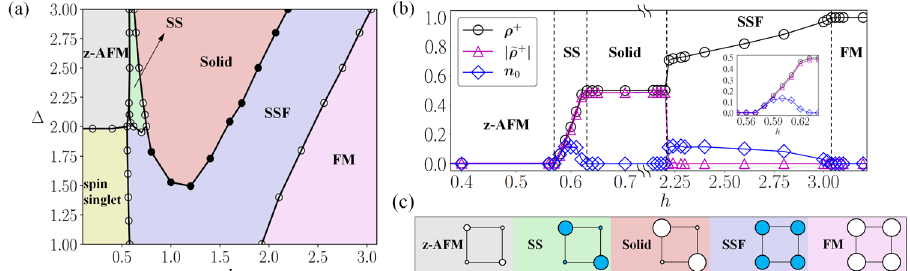
Fig. 3 The full phase diagram and detailed patterns. a The anisotropy- fi eld phase diagram for 2D XXZ Kondo necklace model with θ = 0.4 π ( J ≅ 0.31 and K ≅ 0.95), as de fi ned in Eqs. (2) and (3). h stands for the fi eld strength and Δ represents the strength of XXZ anisotropy. z-antiferromagnetic, spin supersolid, spin super fl uid, and ferromagnetic phases are abbreviated into z-AFM, SS, SSF, and FM separately. The SS phase lies in the range 0.57 ≲ h ≲ 0.7 with Δ ≳ 2. Filled and empty circles indicate the fi rst-order and second-order phase boundaries, separately. A more careful investigation for those continuous boundaries is non-trivial and thus we will leave it for the future works. b Order parameters along with h for Δ = 3. Their de fi nitions can be found in Eqs. (5), (7), and (8). The inset shows the results obtained using bond dimension D = 5 (dimension for environment tensors χ = 25), focusing on the SS area. c The triplon con fi gurations for each phase. Within the 2 × 2 unit cell, the size of each lattice site stands for the magnitude of ρ þ i . Blue (white) color re fl ects nonzero (zero) condensation ( n 0 ). Here, with blue color it indicates U(1) symmetry breaking. Note that for z-AFM, ρ þ i has a checkerboard pattern with a small but nonzero on-site magnitude, and thus the homogeneity is broken and we have small but nonzero ~ ρ þ